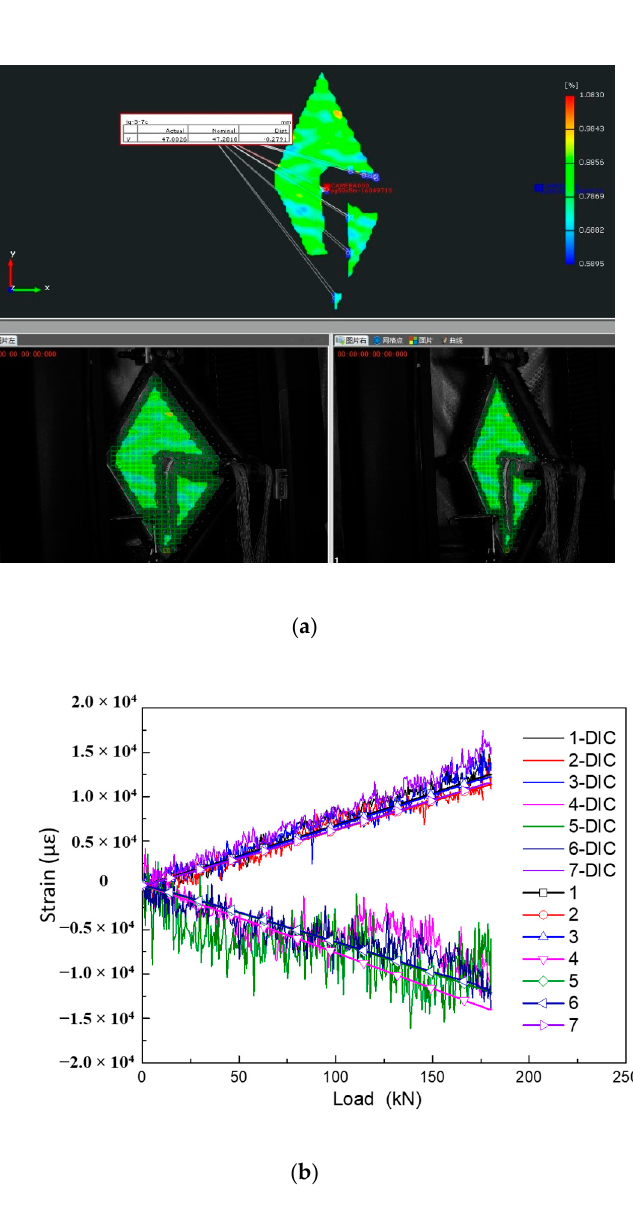
Figure 18. Comparison of DIC data and strain gauge data for shear test at the positive side: ( a ) DIC strain image; ( b ) shear strain curves.